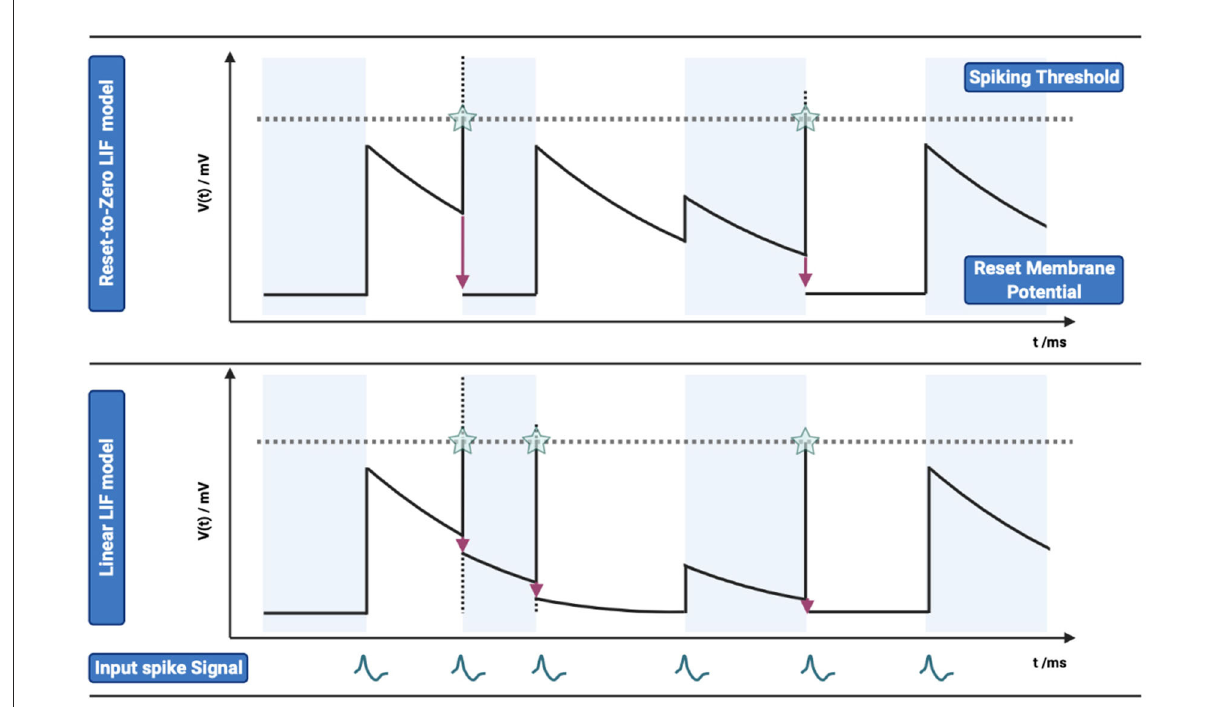
FIGURE2 Comparison of membrane potential changes between Reset-to-Zero LIF model and Linear LIF model. (TOP) Reset-to-Zero LIF model, the membrane potential will be reset to zero ( V reset = 0 mV ). The subfigure shows the input action potential, membrane potential change, spiking threshold and output action potential from bottom to top. (Bottom) Linear LIF model, membrane potential will subtract the spiking threshold at the time when it exceeds the